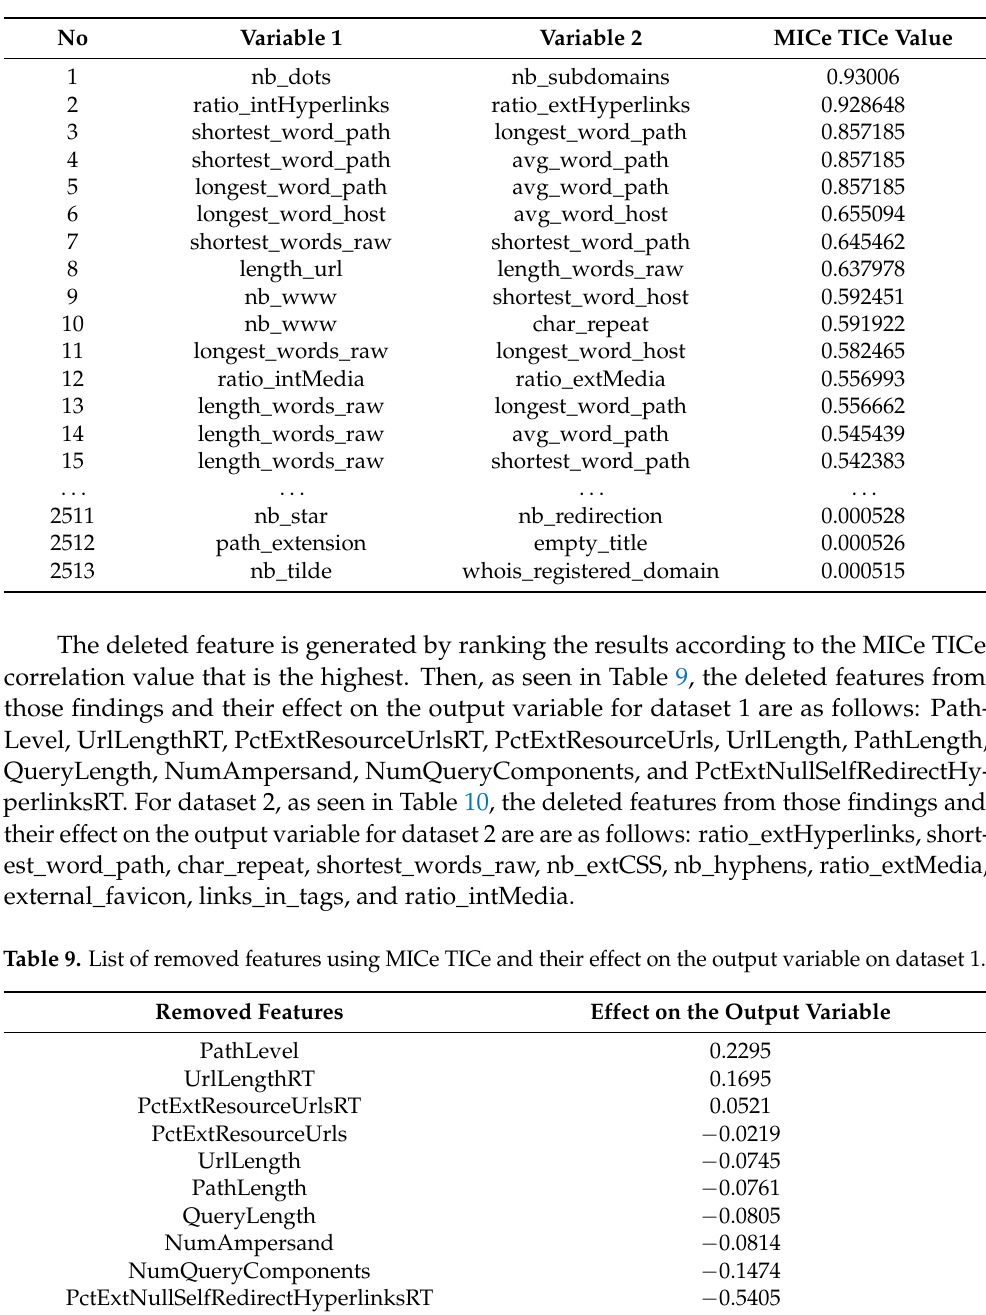
Table 8. MICe TICe correlation value between features on dataset 2.